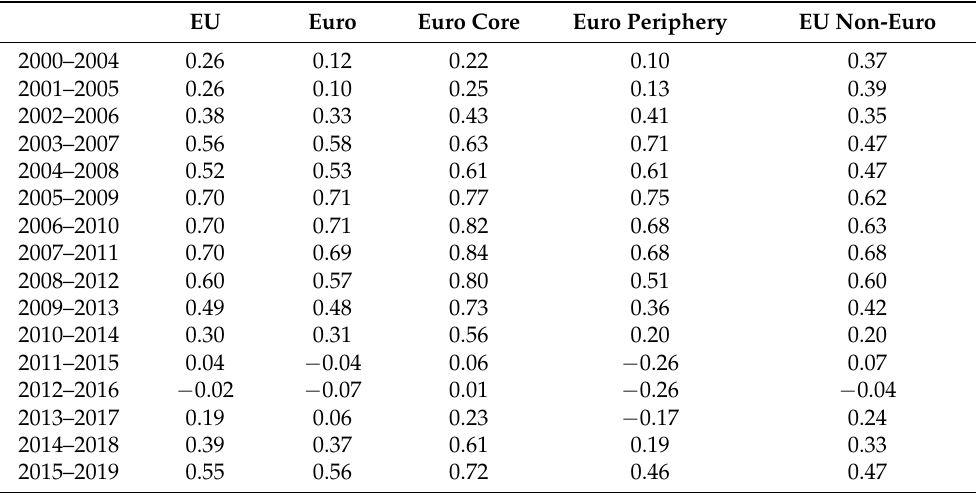
Table 6. Government budget balance as a percentage of GDP—averages of country-level correlation coefficients for different country groups. EU Euro Euro Core Euro Periphery EU